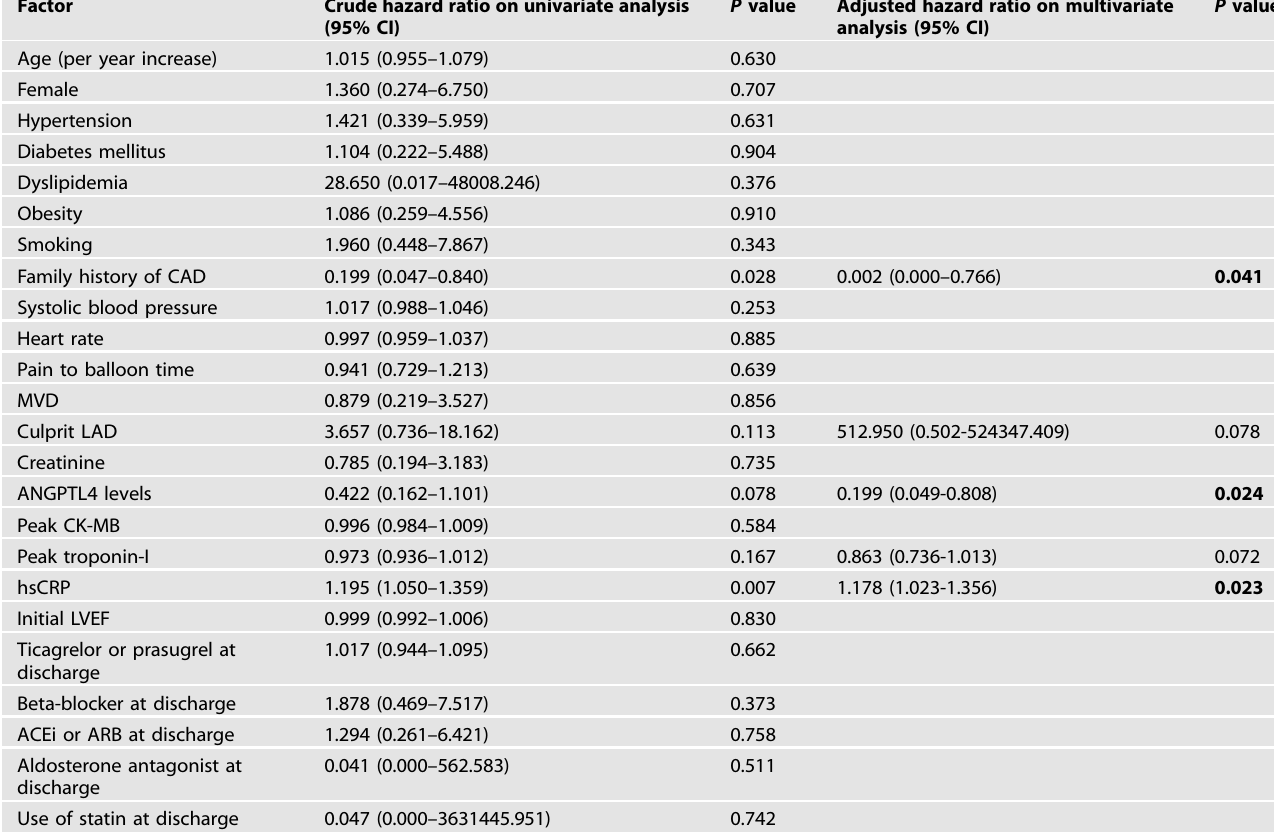
Table 3. Factors associated with events of plaque